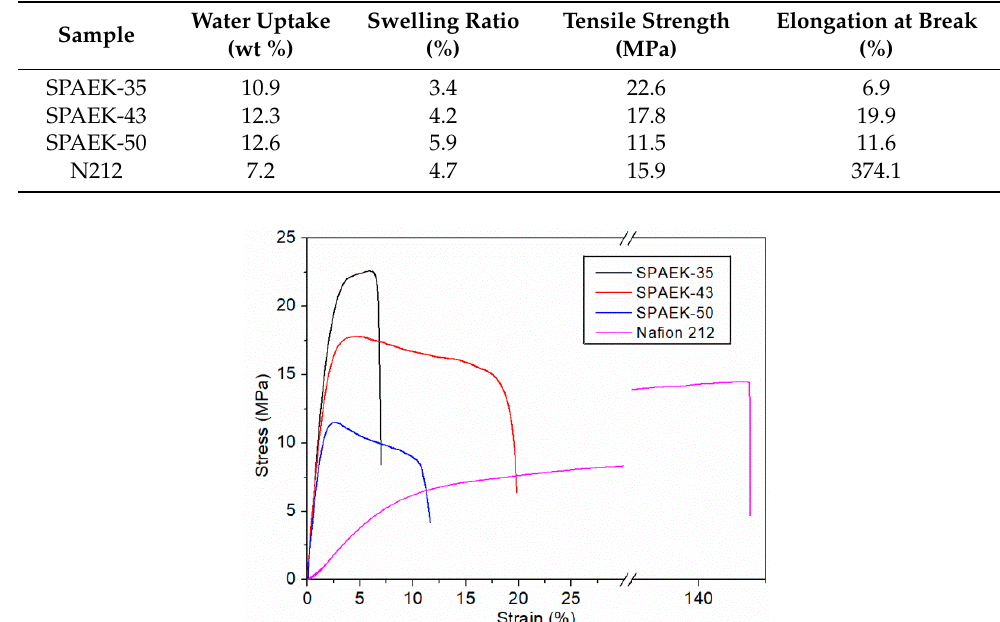
Figure 9. Tensile properties of SPAEKs under ambient RH.